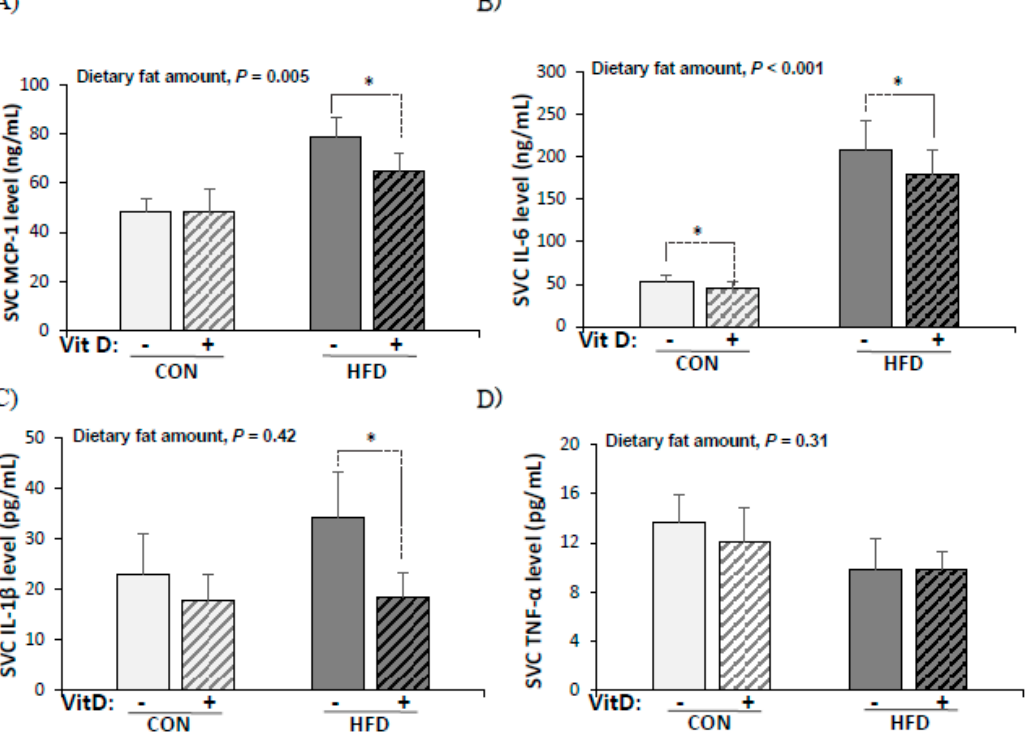
Figure 3. Production of pro-inflammatory cytokines by SVCs from CON and HFD mice ( A ) MCP-1 (ng / mL), ( B ) IL-6 (pg / mL), ( C ) IL-1 β (pg / mL), and ( D ) TNF- α (pg / mL). SVCs were treated with vehicle (0.1% ethanol) or 1,25(OH)2D3 (10 nM) for 24 h before being stimulated with LPS (0.1 µ g / mL) for another 24 hr. Data are presented as mean ± SEM, n = 9~10 for each group. A paired t -test was used to determine the significant e ff ect of in vitro 1,25(OH)2D3 treatment and * indicates a significant di ff erence ( p < 0.05). A student’s t test was used to determine the significant e ff ect of the amount of dietary fat. CON: 10% kcal fat diet; HFD: 60% kcal fat diet.